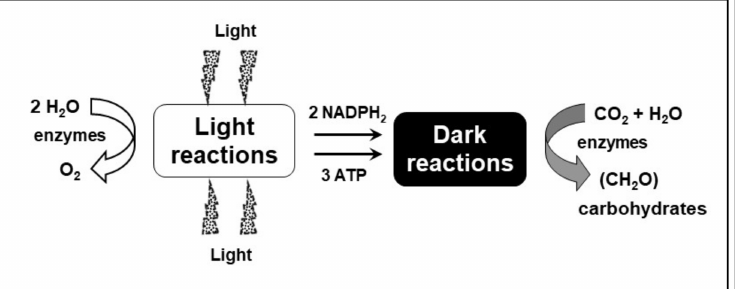
Figure 2. Major products of the light and dark reactions of photosynthesis. The process of oxygenic photosynthesis is divided into two stages, the so-called light reactions and dark reactions. The light reactions include photobiochemical processes—light absorption, water splitting, transfer of excitons through two photosystems in series (PSII and I), and electron and proton translocation resulting in the production of NADPH 2 , ATP, and O 2 . The other phase, the dark reactions that occur in the stroma, represents the reduction of carbon dioxide and the synthesis of carbohydrates using the NADPH 2 and ATP produced in the light reactions (modified from Masoj í dek et al. [21]). Upon illumination, two electrons are extracted from water (oxidation; O 2 is evolved) and transferred through a chain of electron carriers to produce one molecule of NADPH 2